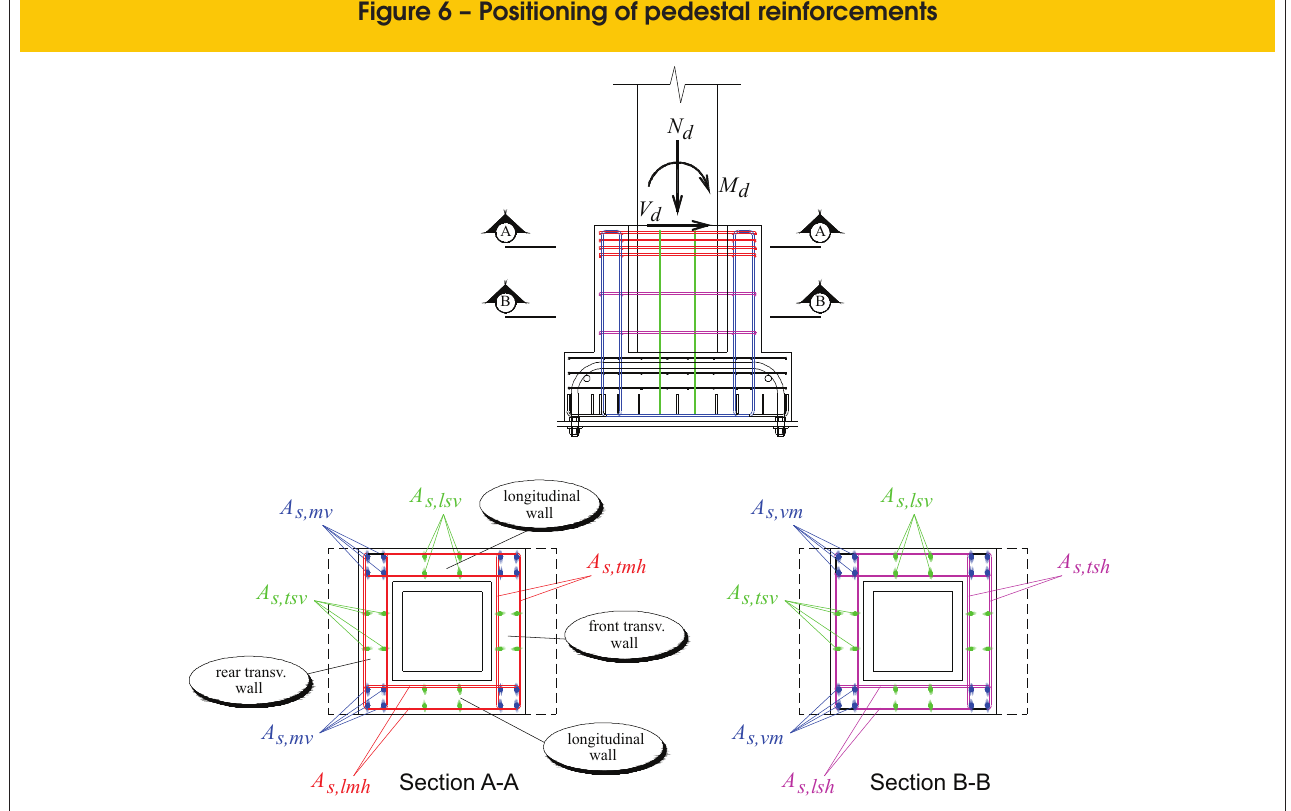
Figure 6 – Positioning of pedestal